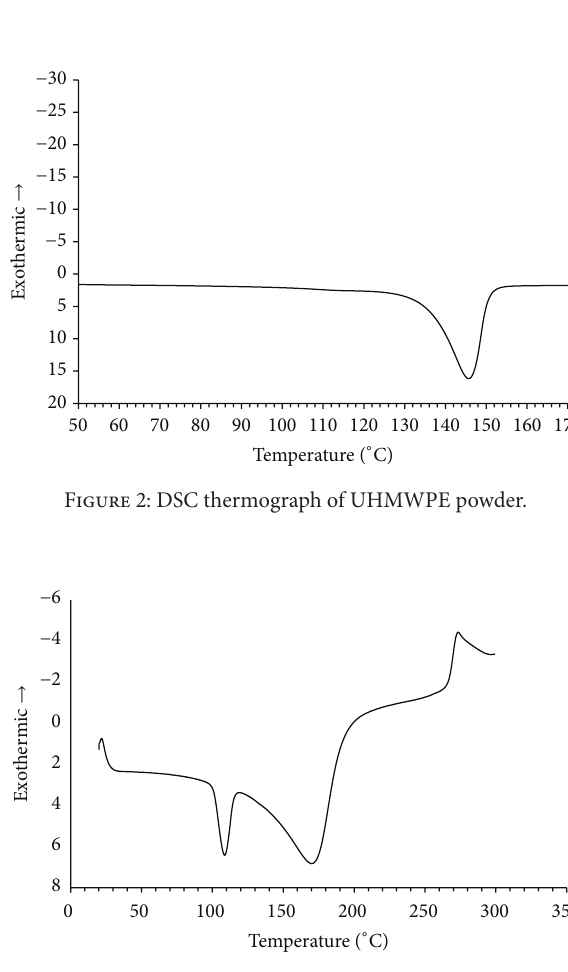
Figure 3: DSC thermograph of